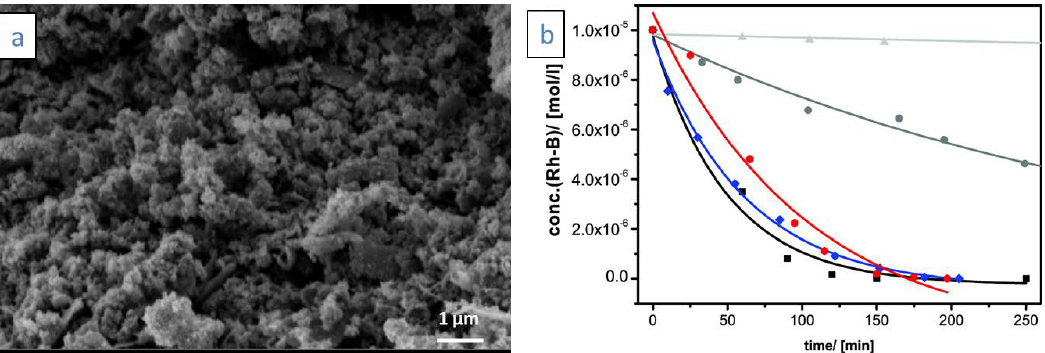
Figure 10. ( a ) Scanning electron microscopy (SEM) image of the ZnO aerogels obtained by full supercritical drying; ( b ) photocatalytic degradation of rhodamine B with: ZnO aerogel as the photocatalyst (first cycle: black, second cycle: blue, third cycle: red); commercial ZnO as reference photocatalyst (dark grey); with no photocatalyst (light grey). (Adapted with permission from [5]. Copyright American Chemical Society, 2010).